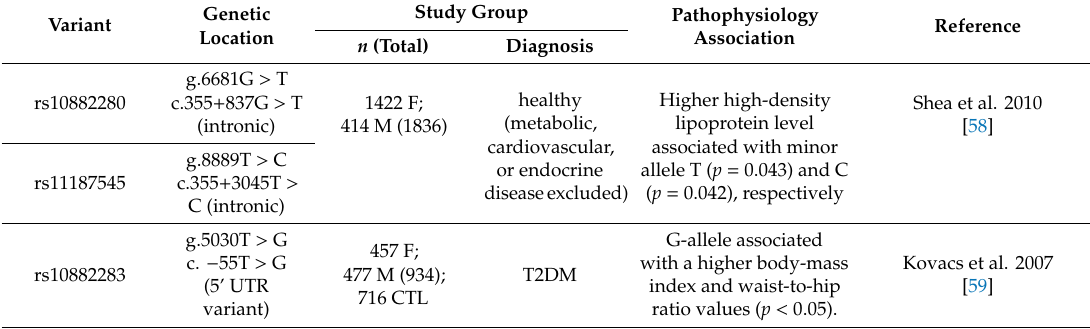
Table 2. RBP4 gene variants investigated as risk factors of cardiovascular diseases in